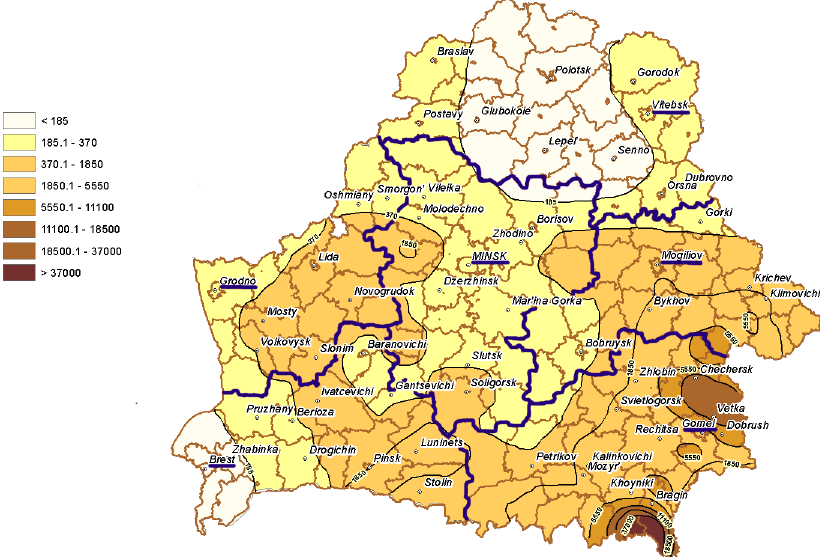
Fig 2. 131 I deposition density (kBq/m 2 ) in the soil of Belarus as of May 10, 1986 [11]. Borders and administrative centers of oblasts are highlighted in